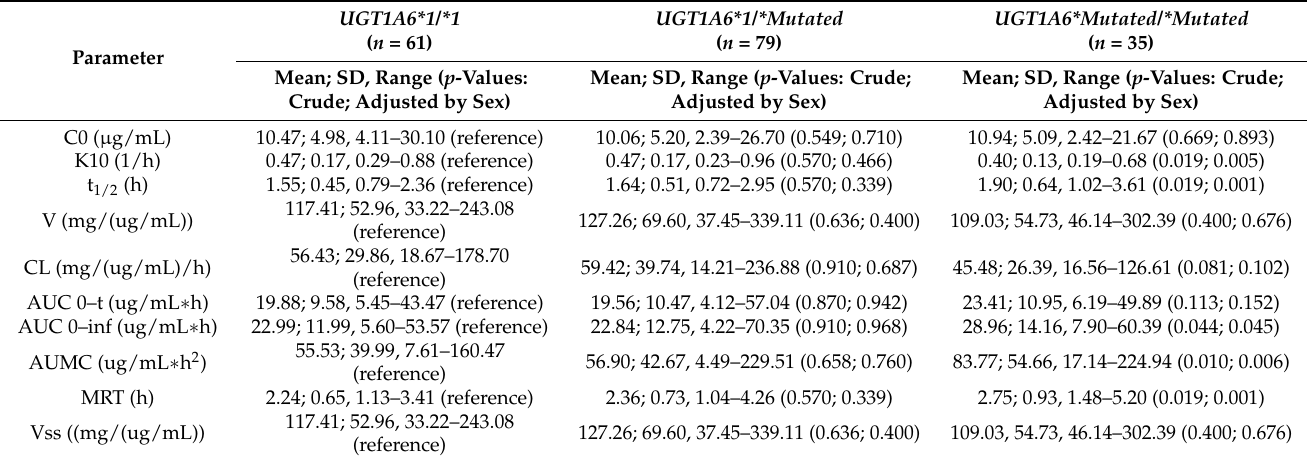
Table 6. Acetaminophen pharmacokinetics according to UGT1A6